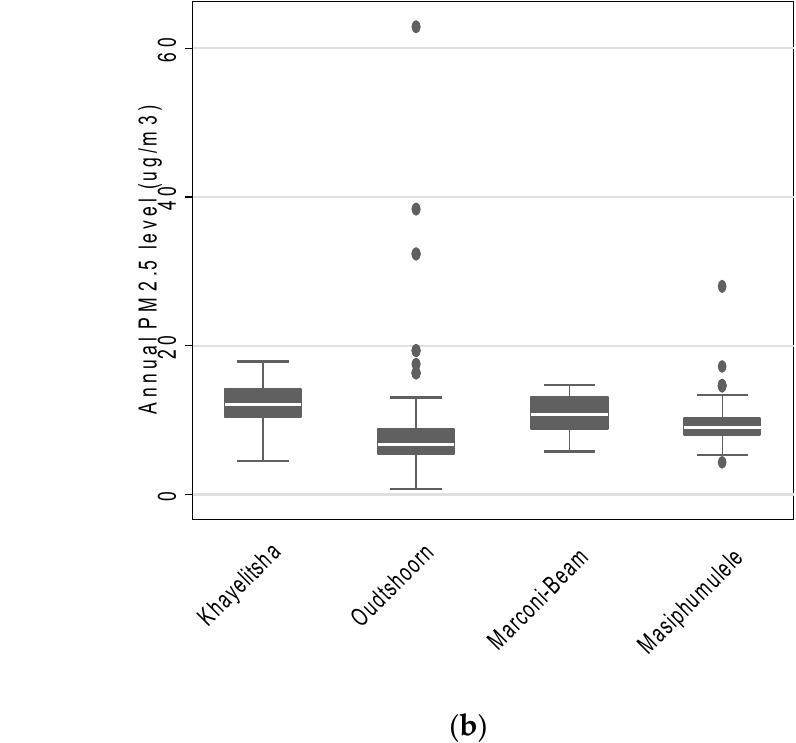
Figure 1. The distribution of annual estimates of ( a ) NO2 and ( b ) PM2.5 concentrations across the four study areas based on LUR modelling.